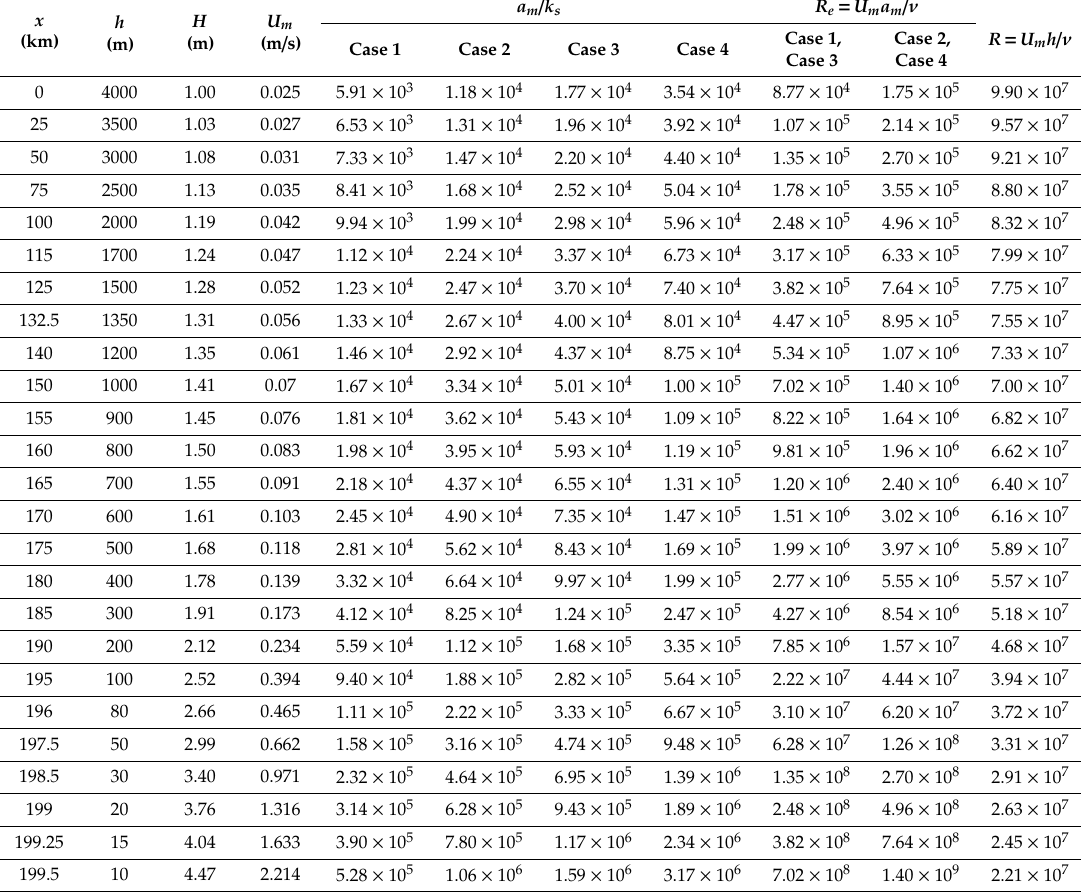
Table 3. Full-range equations for the wave friction coe ffi cient and wave boundary layer thickness. (a) (b) Wave Friction Coe ffi cient Wave Boundary Layer